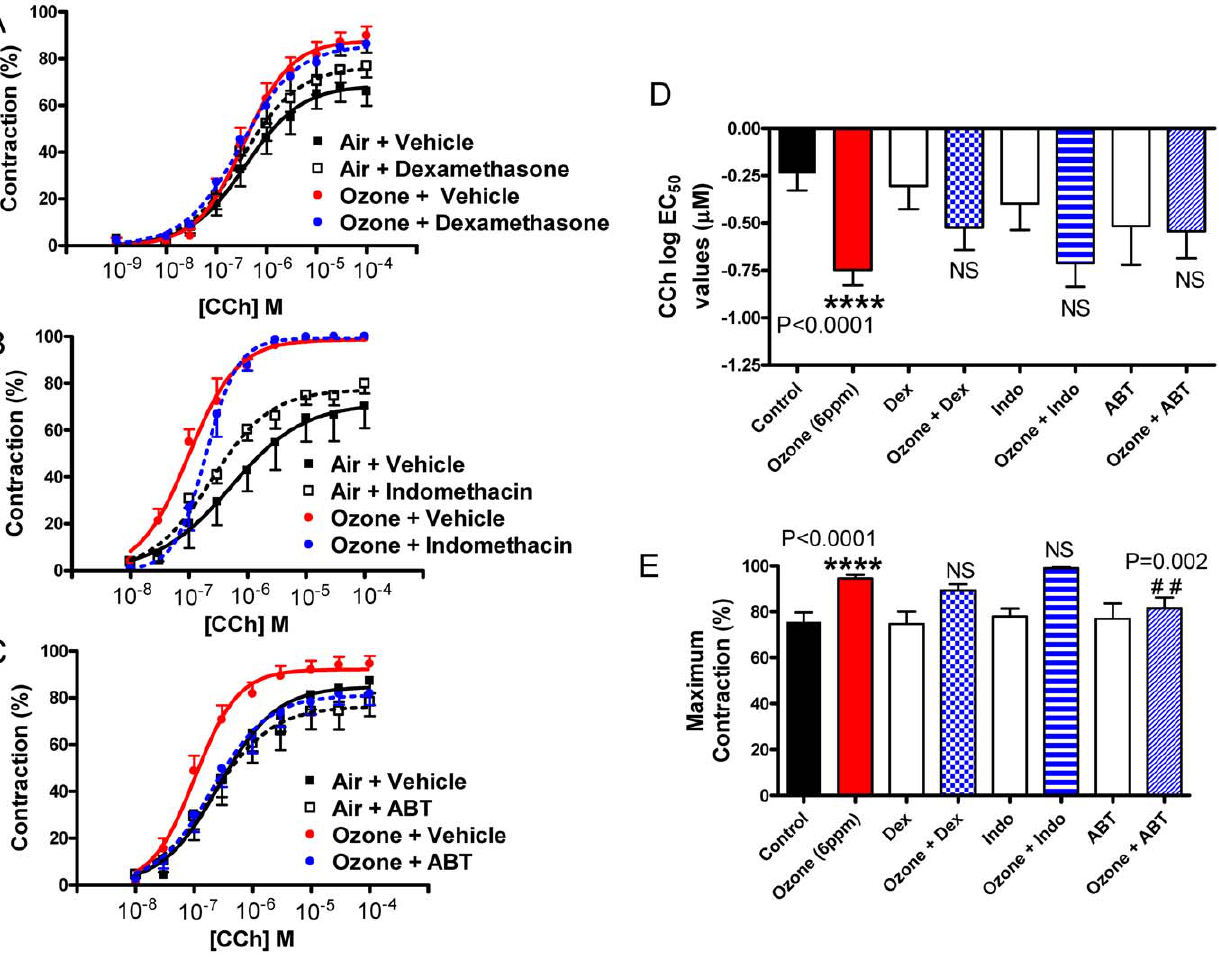
Figure 6. CYP inhibition abrogates ozone-induced increases in airway sensitivity. Mice were administered either (A) dexamethasone (2.5 mg/kg; 18 h prior); (B) indomethacin (10 mg/kg; 2 hr prior); or (C) ABT (50 mg/kg; 18 hr prior) to ozone (6 ppm, 2 h; T=0 h) exposure, with control mice exposed to filtered air. Lung slices were prepared, and airways were contracted to carbachol (CCh) to create concentration response curves, from which (D) log EC 50 values and (E) maximum contractions were calculated. Data is expressed as Mean 6 SEM shown. NS = Non- significant; **** P , 0.001 vs. control; # # P # 0.01 vs. ozone. At least 6 animals were used in each group, and never more than 10.